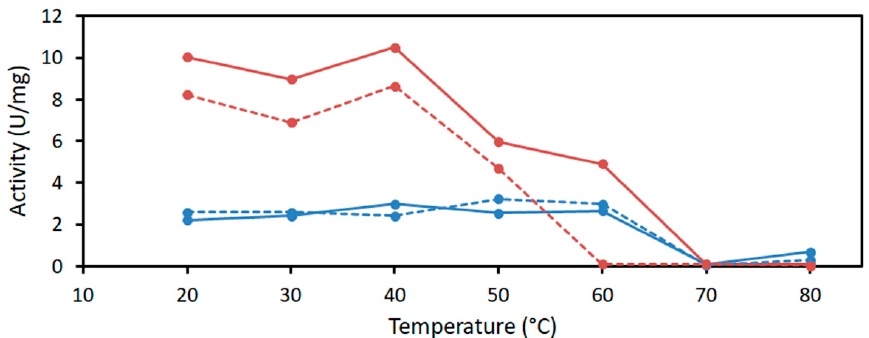
Figure 1. Overview of residual activity after incubation of Pa DERA (red) and Ec DERA (blue) at different temperatures (20–80 °C) in TEA buffer (100 mM, pH 7.0) measured after 10 min (continuous lines) and 60 min (dotted lines) of incubation. The activity was measured using the standard assay procedure at 25 °C.